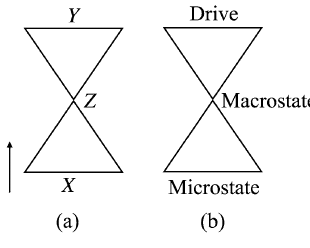
Figure 1. Parallel between two structures: ( a ) Bottleneck neural network, which performs representation learning. ( b ) Nonequilibrium-statistical-mechanics problem.